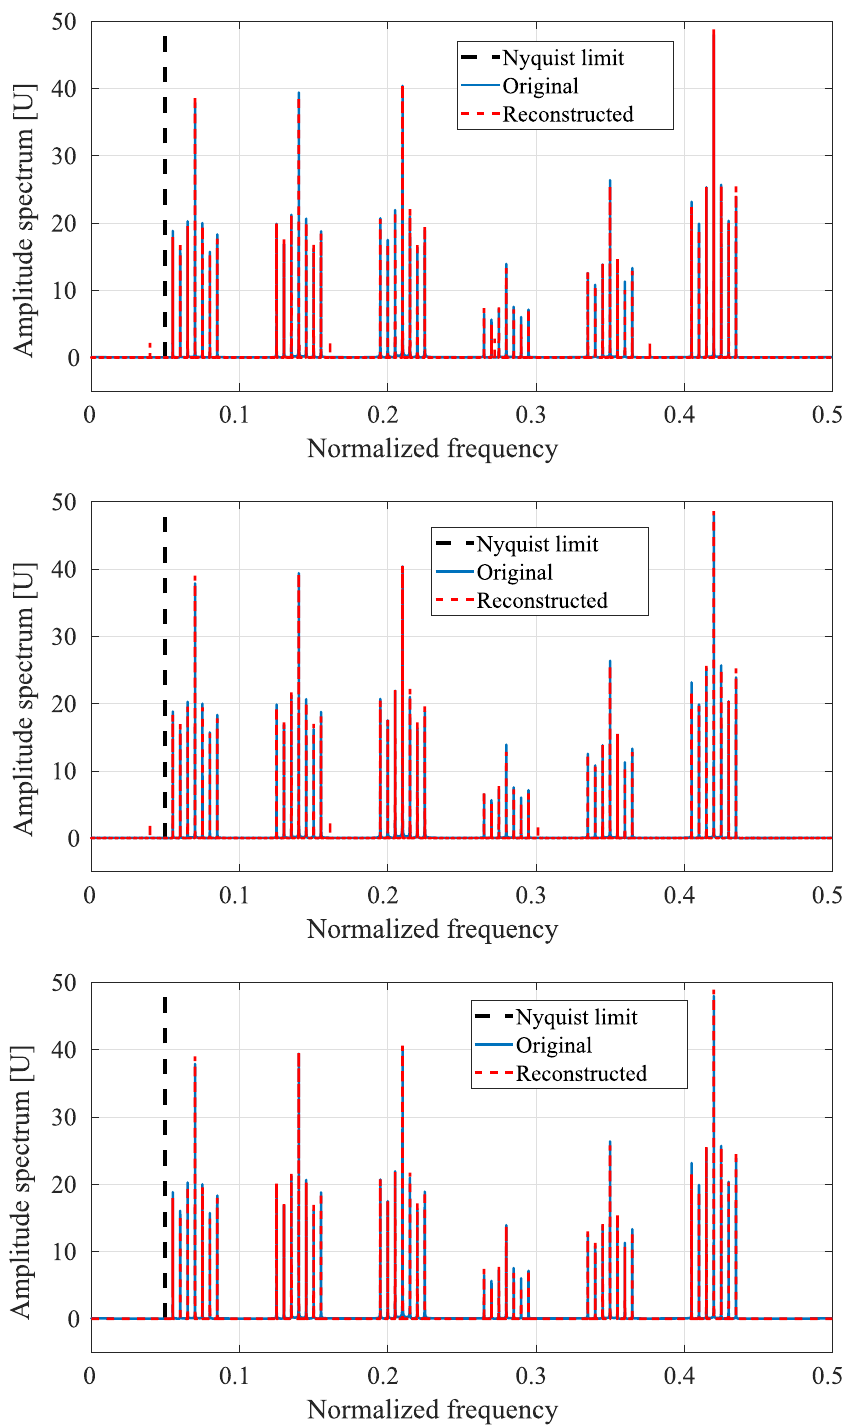
Figure 4. Reconstructed spectra using (from top to bottom) t-univ, H-univ, and scale mixture of multivariate Gaussian (SMG)-block for compression rate 0.9 and noise level 13.97 dB